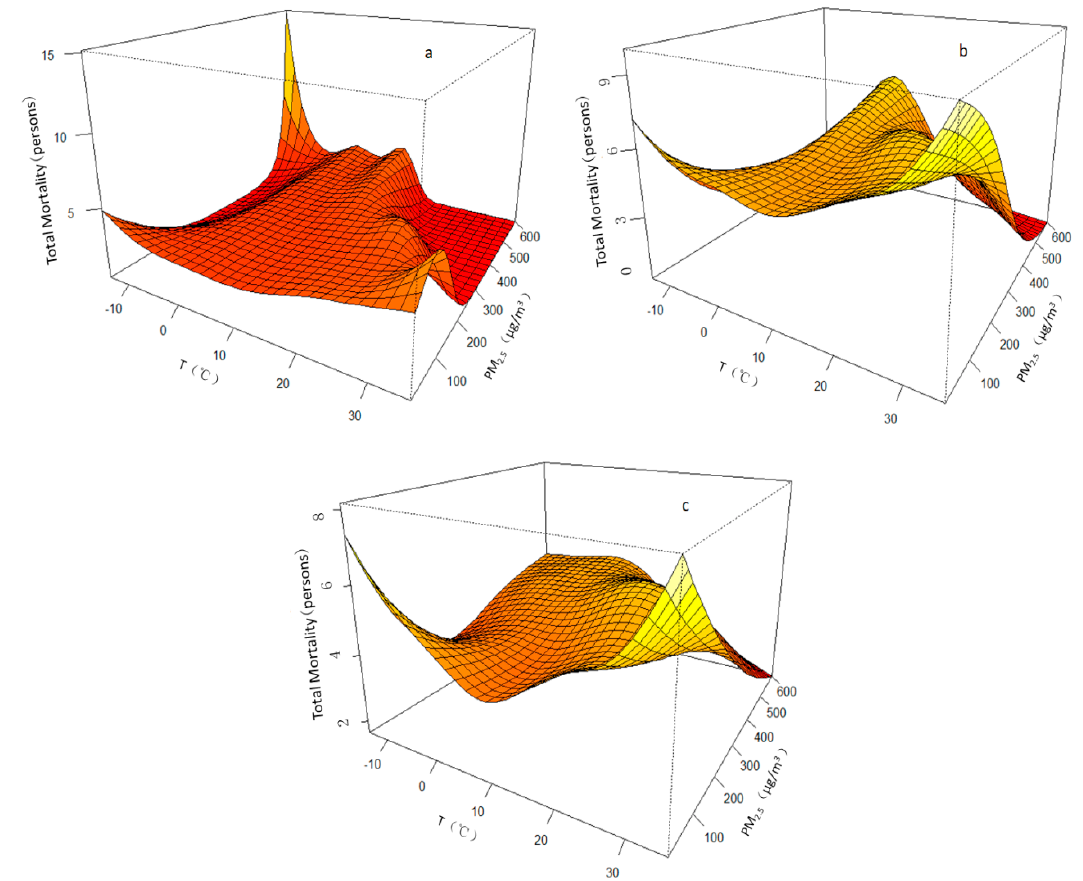
Figure 4. Smooth curved surface diagram of the synergistic effect of the daily average temperature and PM 2.5 on the death toll of circulatory system diseases in Shijiazhuang City from 2014 to 2016. ( a ) Total population, ( b ) males and ( c ) females.